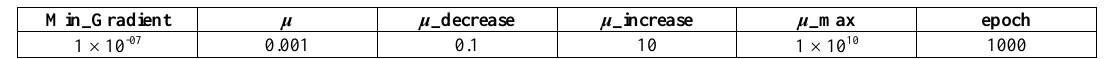
Table 1. Training parameters.